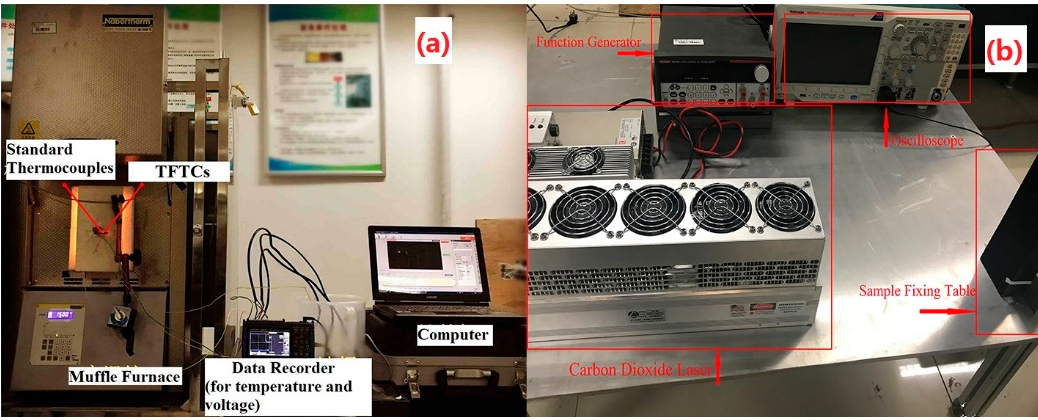
Figure 2. Static ( a ) and dynamic ( b ) high-temperature thermoelectric measurement experiment rig.